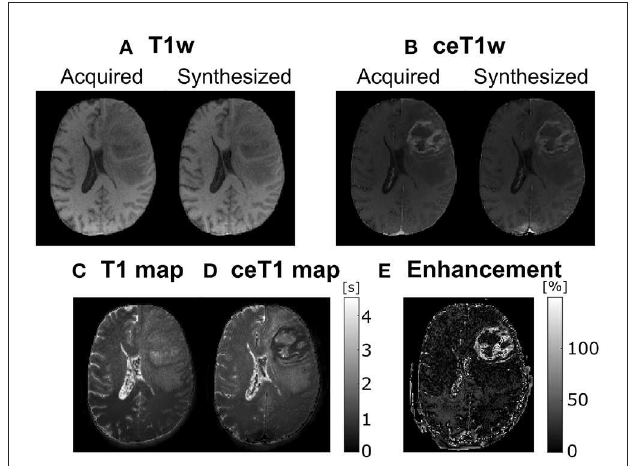
FIGURE1 A representative axial slice of parametric maps computed by the self-supervised CNN and the synthesized images. (A) Acquired and corresponding synthesized native T1w from the computed T1, T2, and PD maps. (B) Acquired and corresponding synthesized contrast-enhanced T1w (ceT1w) from the contrast-enhanced T1 (ceT1), T2, and PD maps. (C) native T1 map. (D) ceT1 map. (E) Corresponding enhancement map computed as the subtraction between (C) and (D) . T1 and ceT1 maps are measured in seconds (s), whereas the enhancement map is measured in